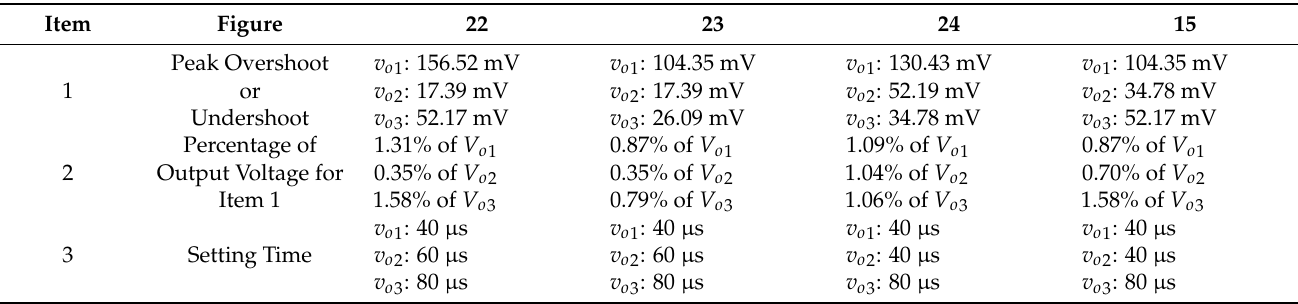
Figure 25. Dynamic response waveforms on condition that the main output load is changed from rated load to light load and the first and second secondary outputs are located at rated load. Table 4. Results for dynamic cross regulation.